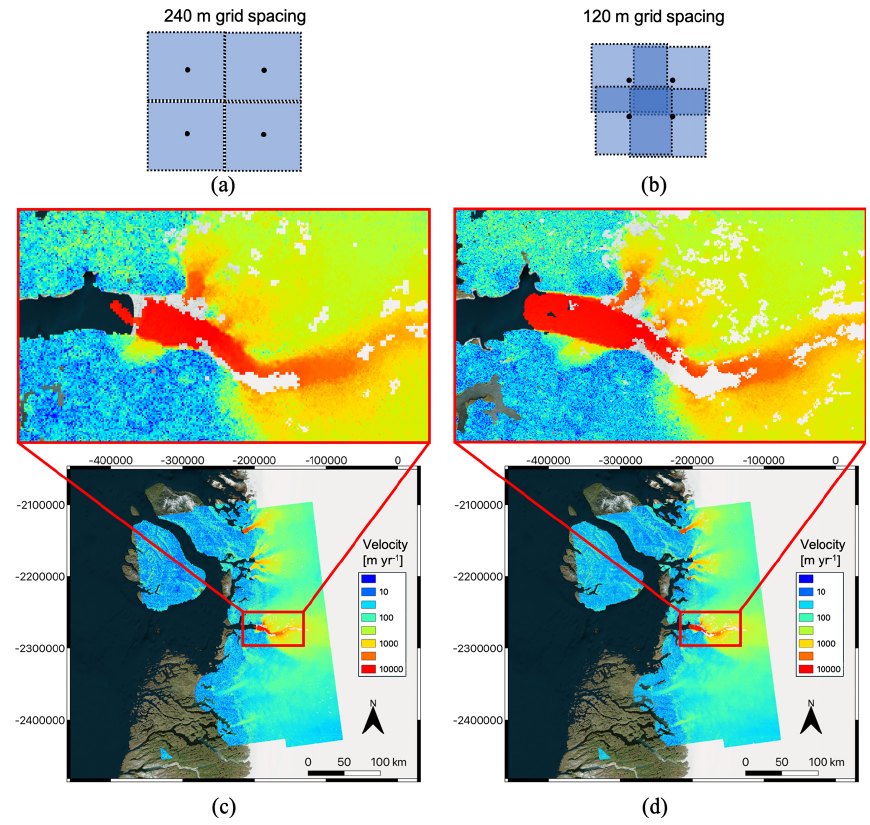
Figure 4. Comparison between a 240m posting grid and a 120m posting grid: (a) 240m grid with non-overlapping search chips, (b) 120m grid with 50% overlapping search chips, (c) autoRIFT -estimated ice velocity magnitude for 240m grid, (d) autoRIFT -estimated ice velocity magnitude for 120m grid. The same minimum chip size of 240m is used for both cases. For (c) and (d) , the Sentinel-1 image pair 20170404–20170410 is used in Region 1 (with the close up at the Jakobshavn Isbræ Glacier). Background: © Microsoft Bing Maps